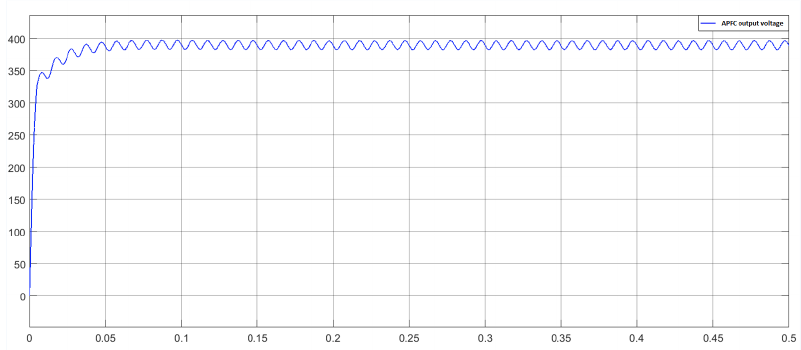
Figure 11. The PFC output voltage.